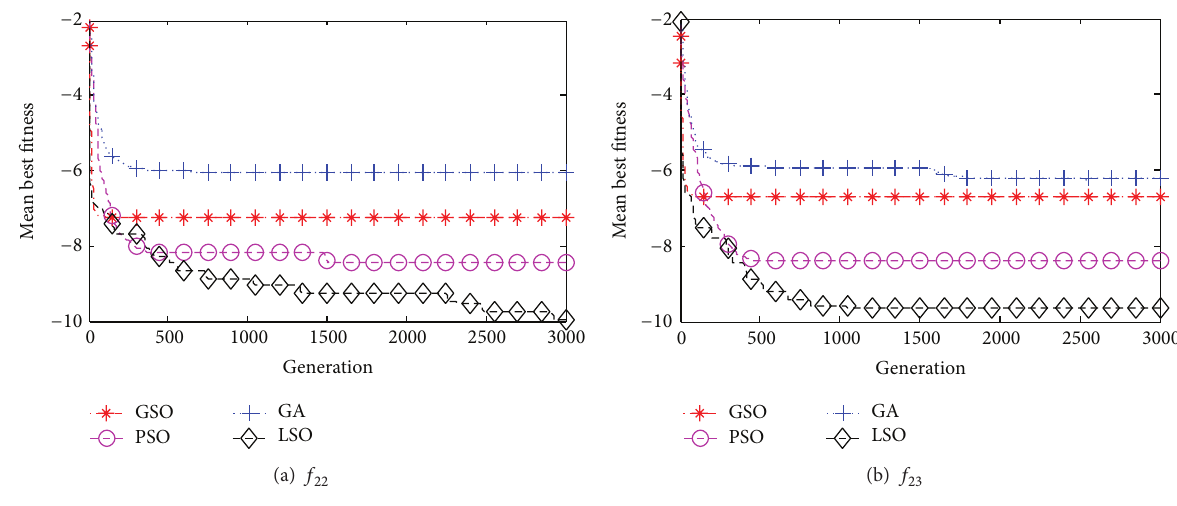
Figure 7: Convergence results of functions 𝑓 22 and 𝑓 23